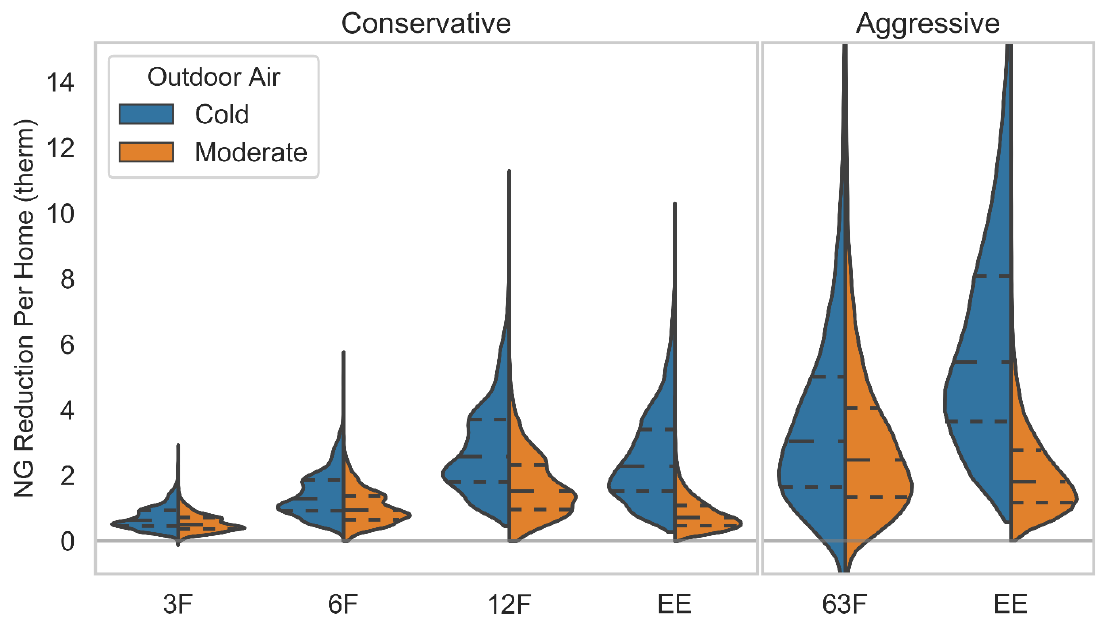
Figure 8. Distributions of total natural gas (NG) reductions from demand response and energy efficient upgrade scenarios from the cold and moderate weather baseline scenarios. Quartiles are represented by the lines inside each plot. The conservative plot displays all modeled homes, while the aggressive plot displays approximately 98% of the modeled homes, omitting extreme high and low data points.